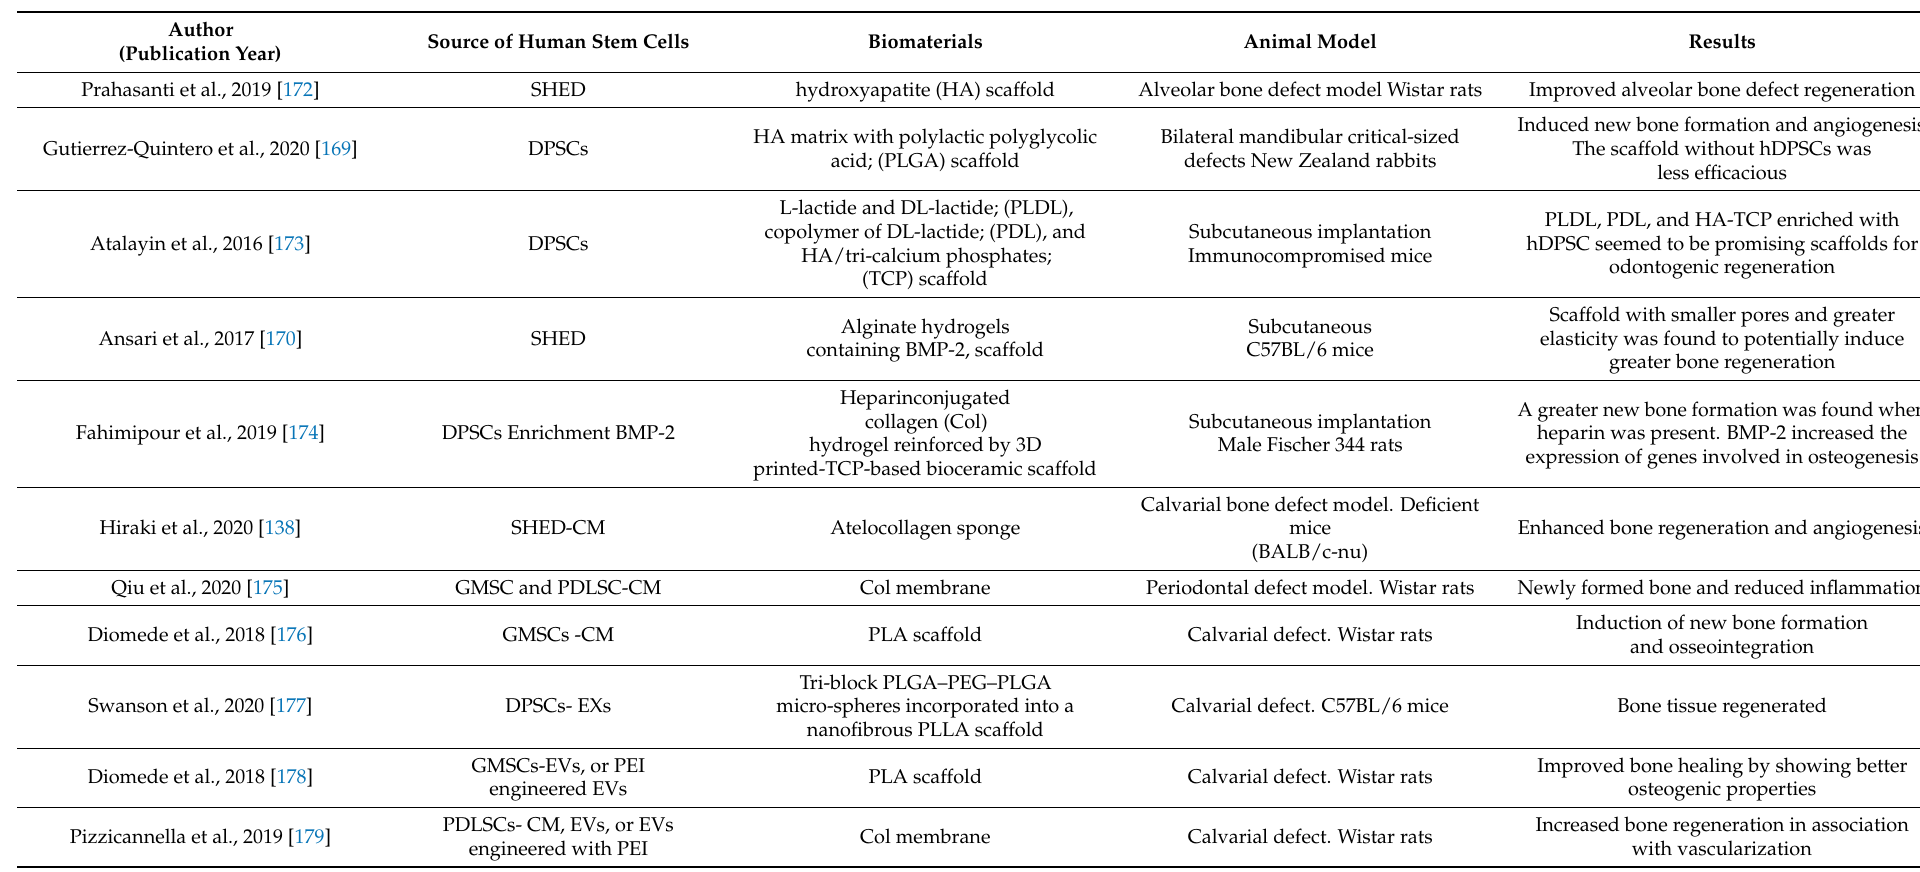
Table 2. The regenerative effect of scaffold-based combined with human dental stem cells and scaffold enrichment with dental MSC-derived secretome used in vivo